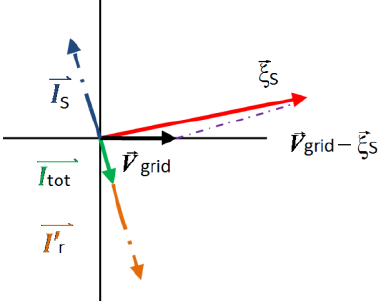
Figure 3. Diagram of the space phasors during the first instants of a voltage dip.